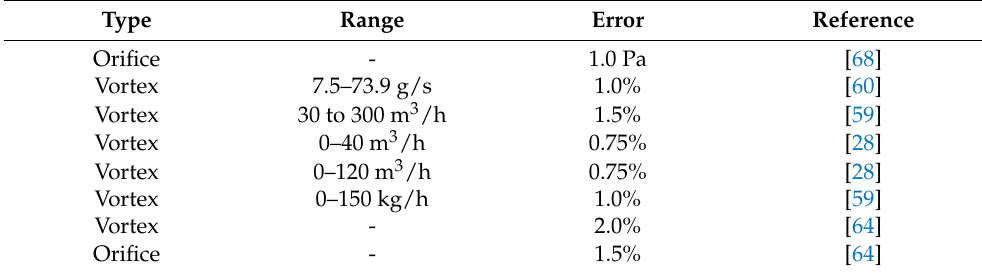
Table 13. Devices used in steam flow